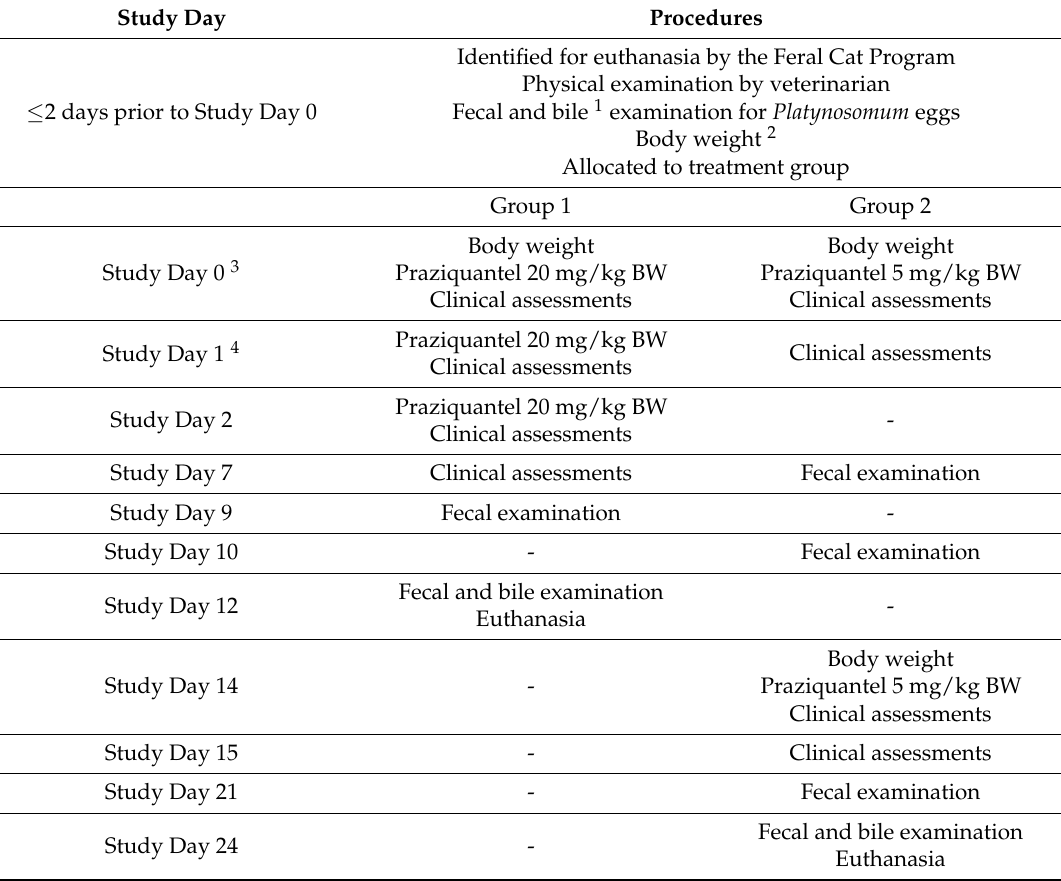
Table 1 lists the schedule of events. Table 1. Schedule of events for cats included in the